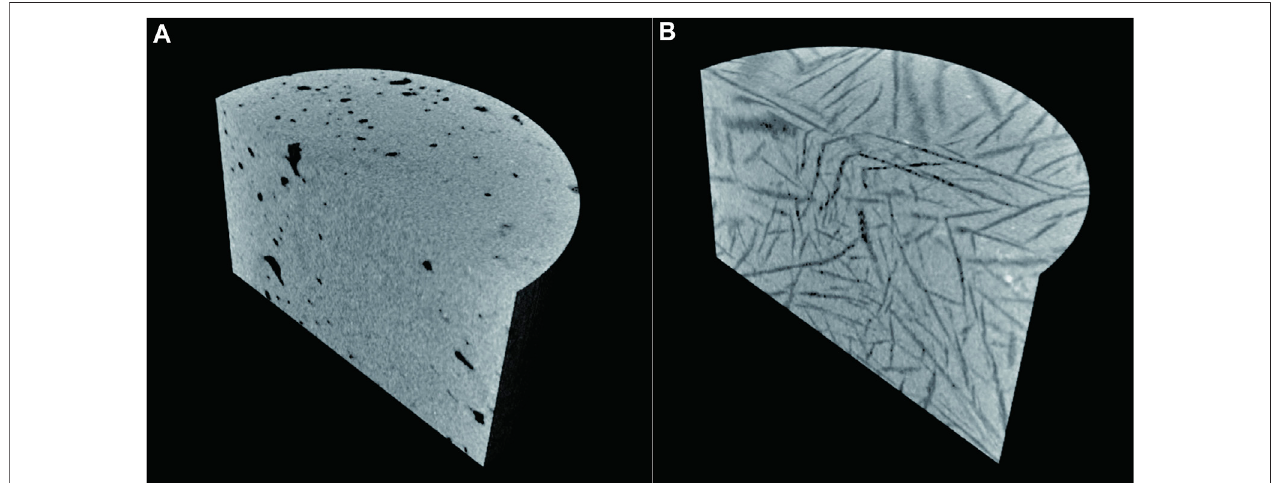
FIGURE 7 | Seismic re fl ection of gas chimney structure in H area of Qiongdongnan Basin.